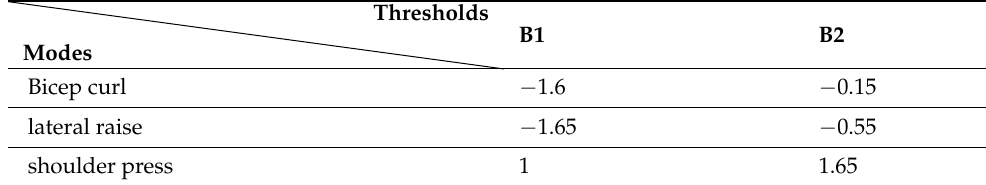
Table 1. Thresholds for three exercise modes.